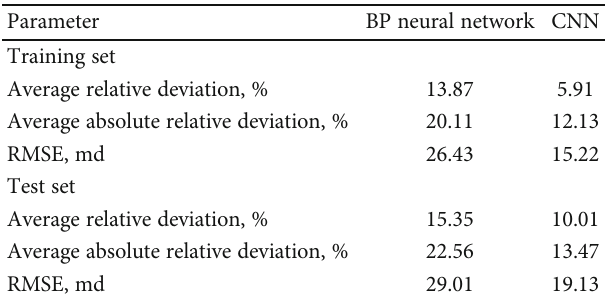
Table 5: The results of statistical error analysis performed in this study for di ff erent neural networks.